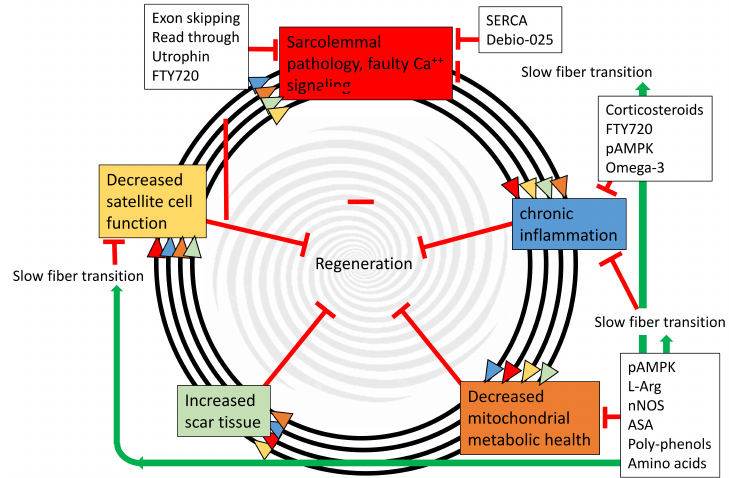
Figure 1. Muscular dystrophy progression is a feed-forward spiral between sarcolemmal pathology, chronic inflammation, decreased mitochondrial health, increased scar tissue, and decreased satellite cell function. The multiple arrows indicate that each of the five pathogenic steps directly accelerates all of the other steps, and all five directly inhibit regeneration. Black boxes indicate therapies directed at specific targets. Importantly, many of these therapies are nutritional/metabolic and can be used in conjunction with other therapies. Green arrows indicate positive effects, and red tees indicate inhibitive affects. pAMPK—phosphorylated AMP-activated protein kinase; L -Arg— L -Ariginine; nNOS—neuronal nitric oxide synthase; ASA—5-aminosalicylic acid; FTY720—Fingolimod; SERCA—sarco/endoplasmic reticulum Ca 2+ -ATPase; Debio-025—a cyclophilin